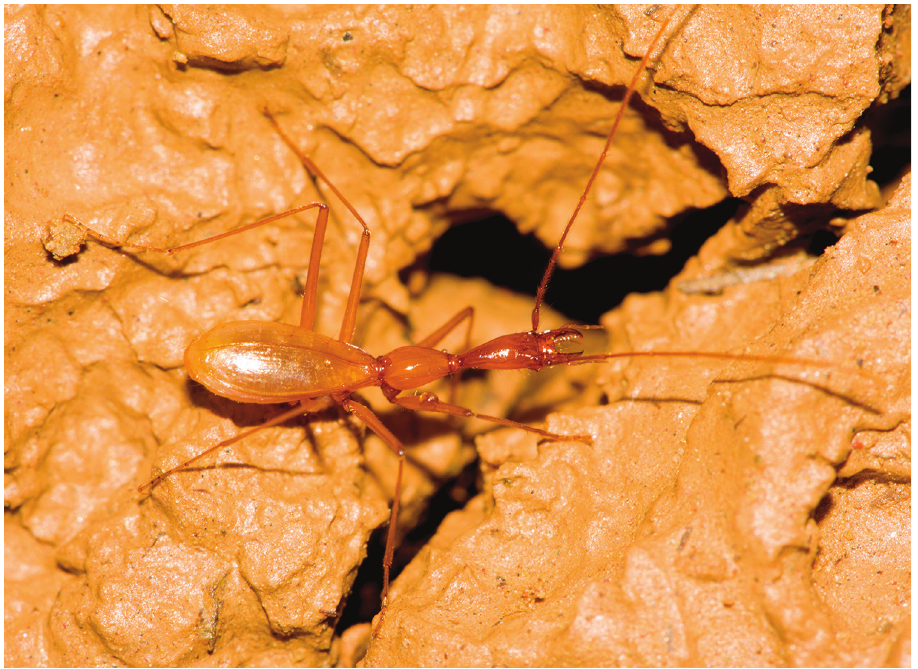
Figure 2. A living exemplar of Dongodytes (s. str.) fowleri Deuve, 1993. Dongodytes (s. str.) tonywhitteni sp.